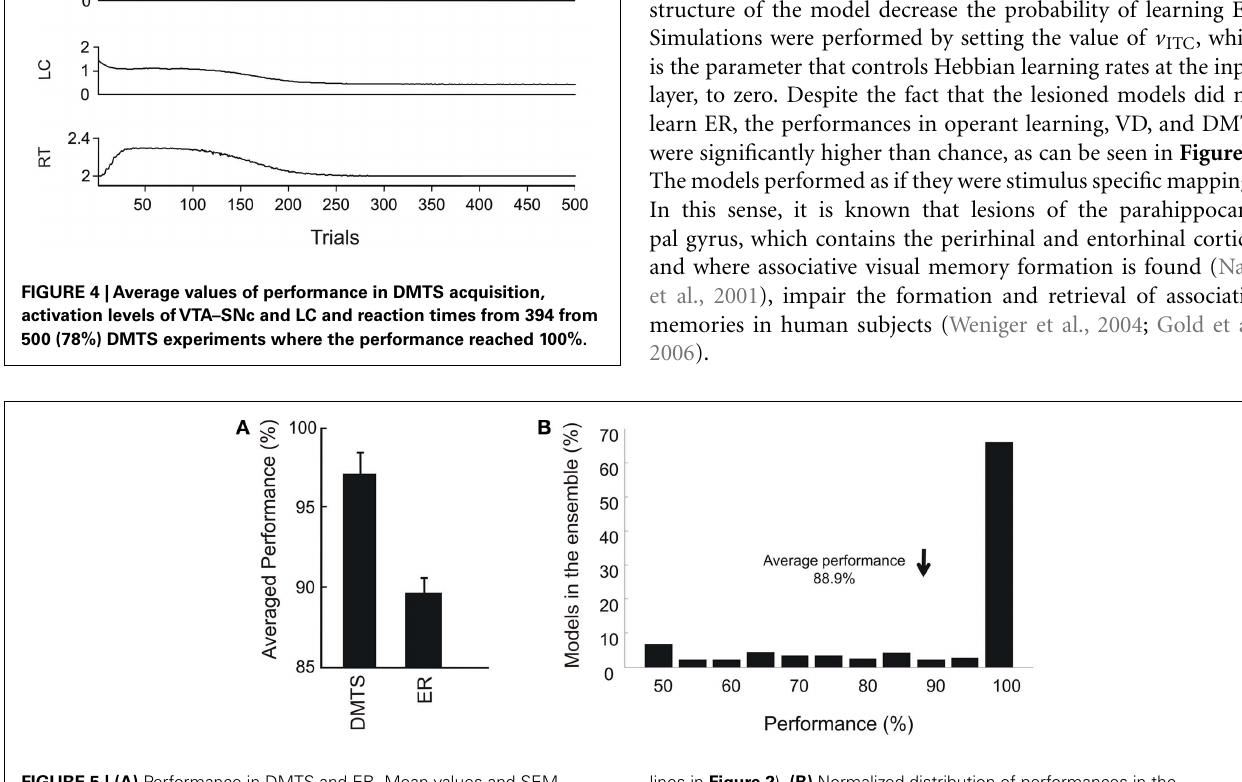
FIGURE 5 | (A) Performance in DMTS and ER. Mean values and SEM were calculated using the first 20 trials after the plateau in correct responses was reached, that is, the same number of trials used for testing equivalence relations (all combinations indicated by dashed